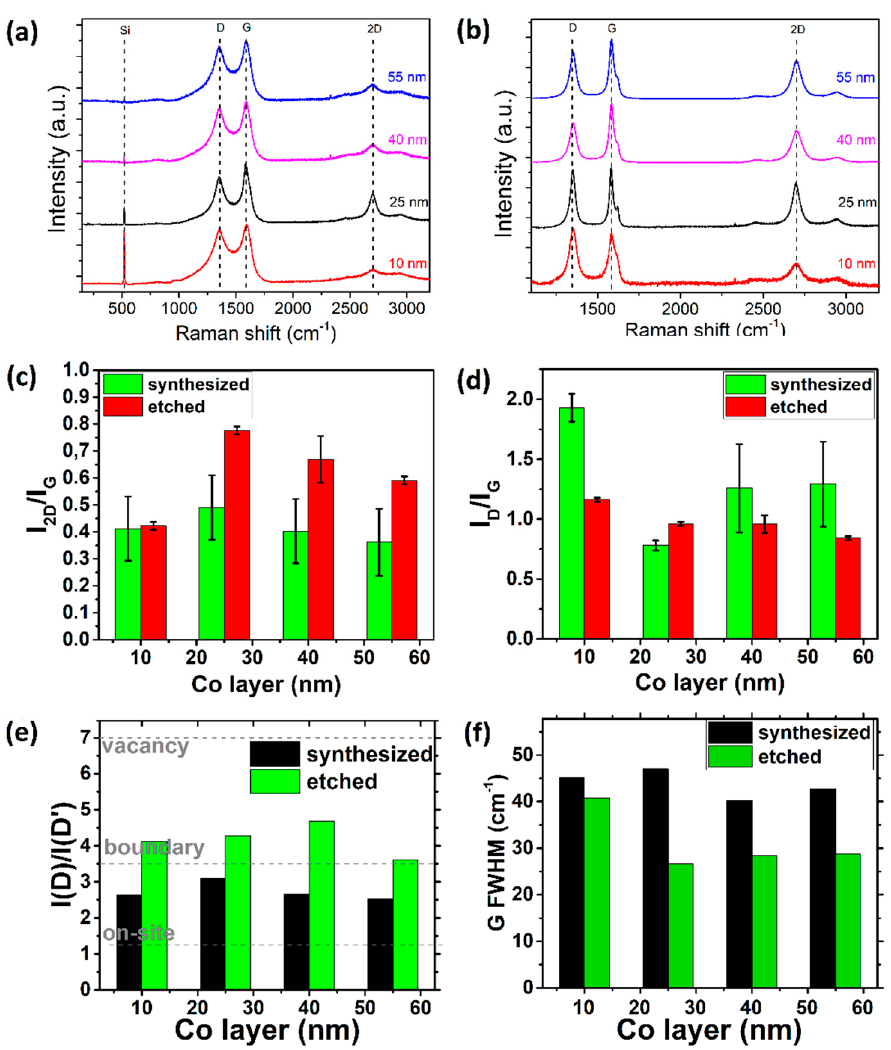
Figure 5. The Co sacrificial layer thickness effects on the structure of graphene grown by a single ‐ step synthesis: the Raman spectra after the synthesis ( a ) and after removing the sacrificial cobalt interlayer ( b ); Raman spectra parameters analyzed: I 2D /I G ( c ); I D /I G ( d ); I D /I D’ ( e ); FWHM(G) ( f ). The synthesis temperature was 700 °C, ion beam energy—800 eV, ion beam treatment time—15